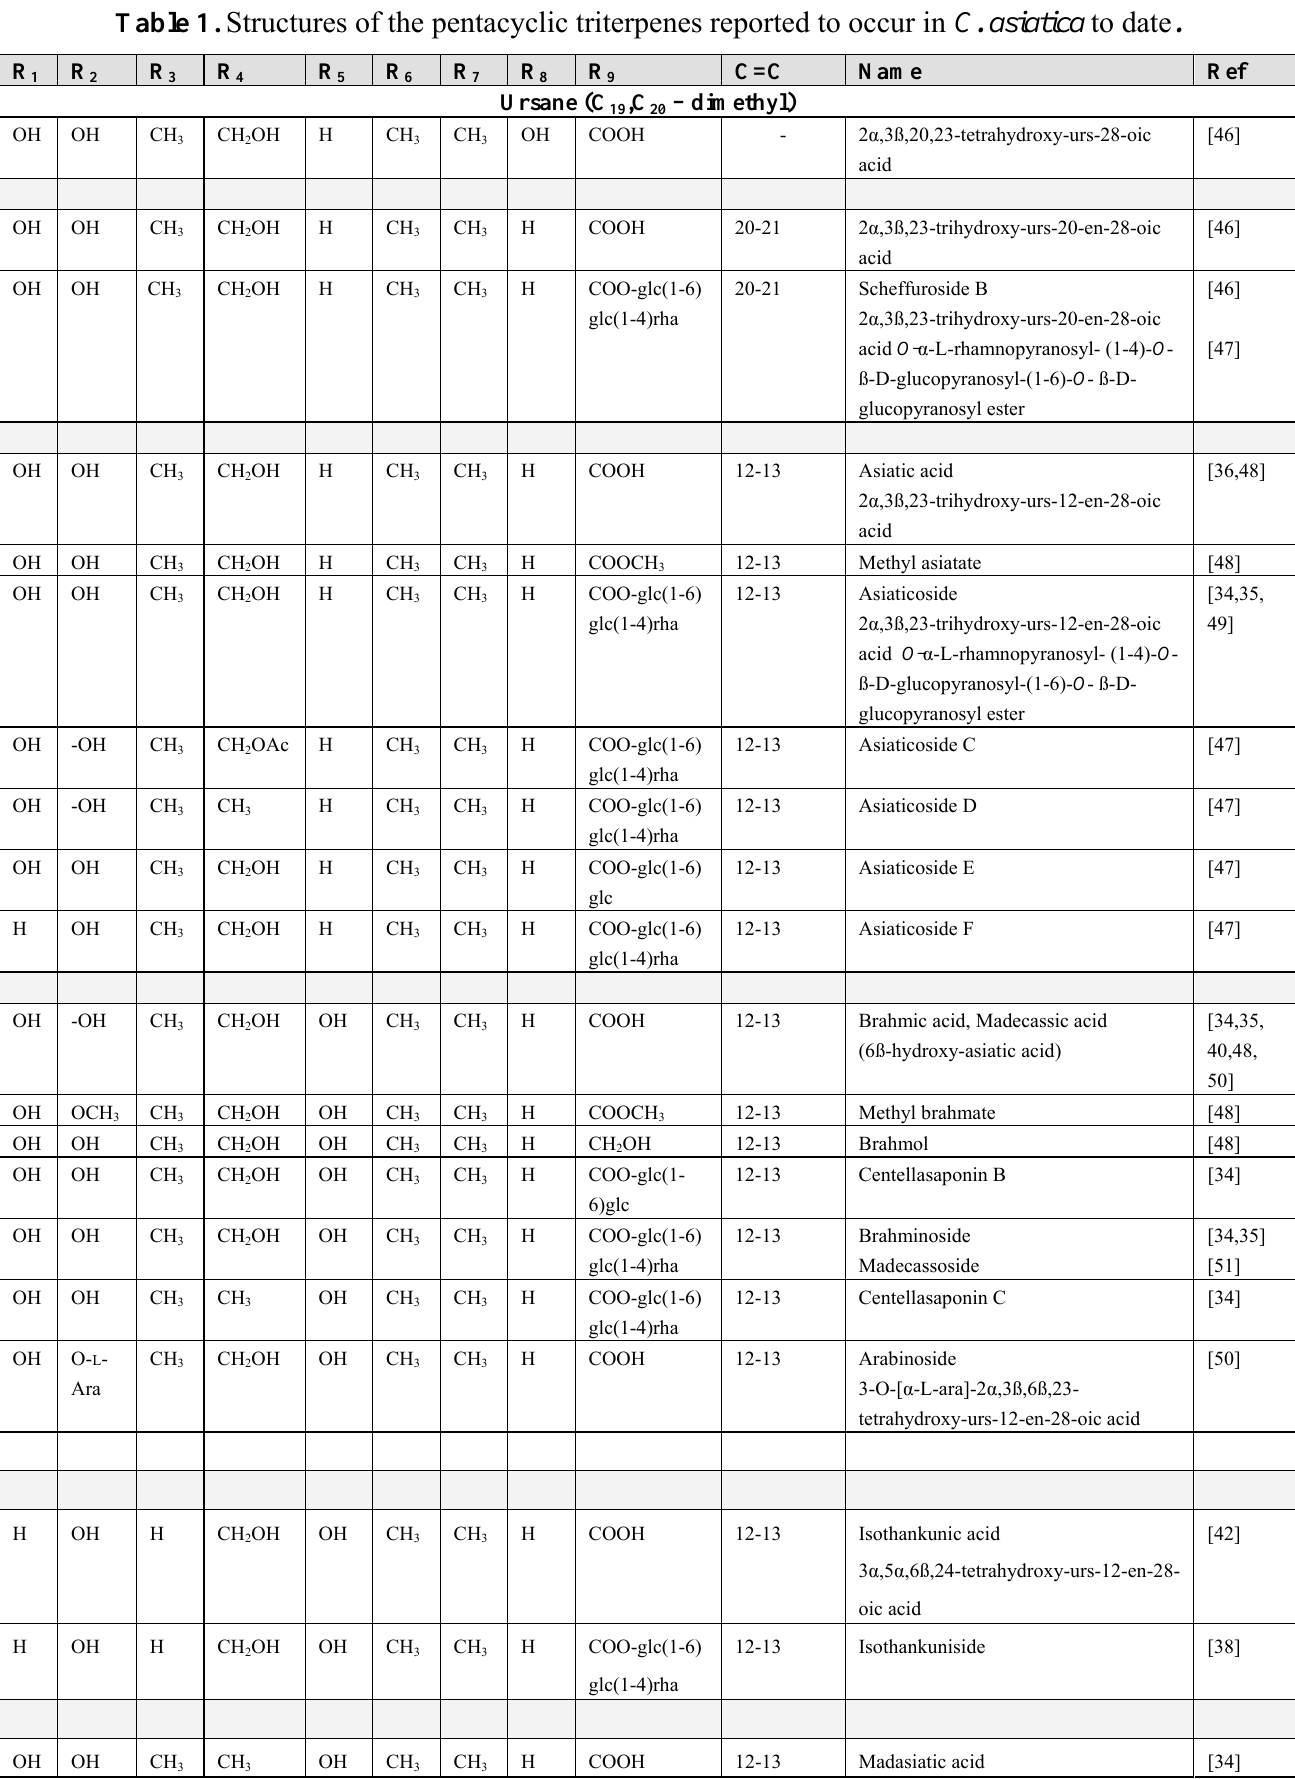
Table 1. Structures of the pentacyclic triterpenes reported to occur in C. asiatica to date . R